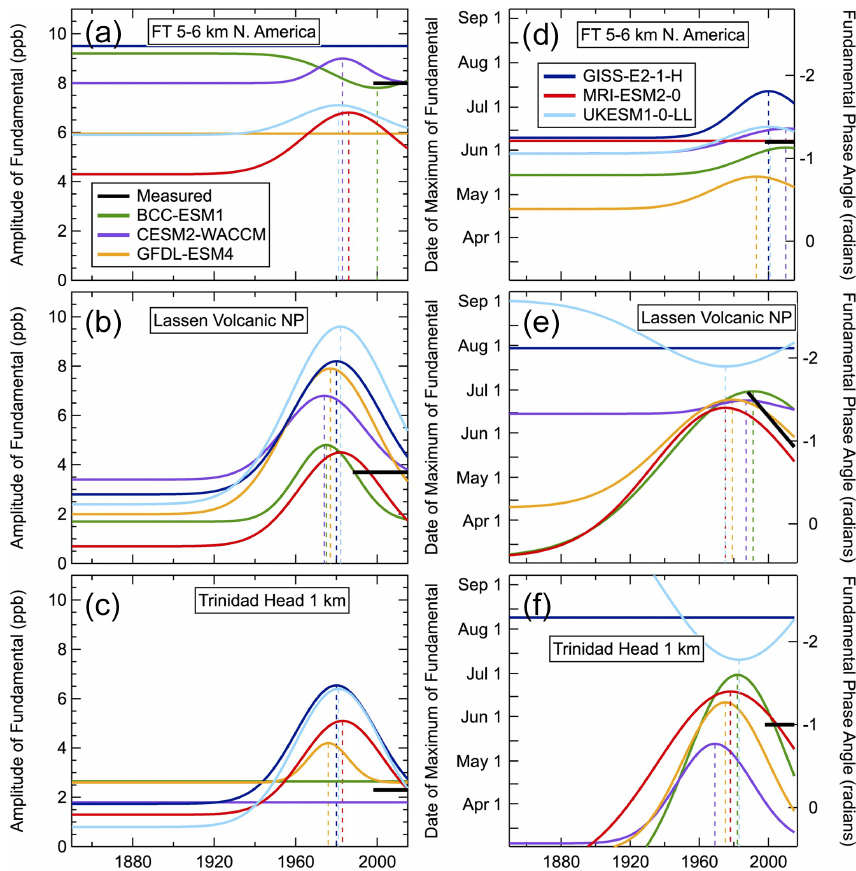
Figure 6. Same as Fig. 5, except for the three North American locations, with expanded ordinate scales on the left panels. The simulated phase of the fundamental at Trinidad Head at 1km goes off-scale for most simulations at some point during the time series; Fig. S6 in the Supplement shows the Trinidad Head phase dependence on an expanded scale.